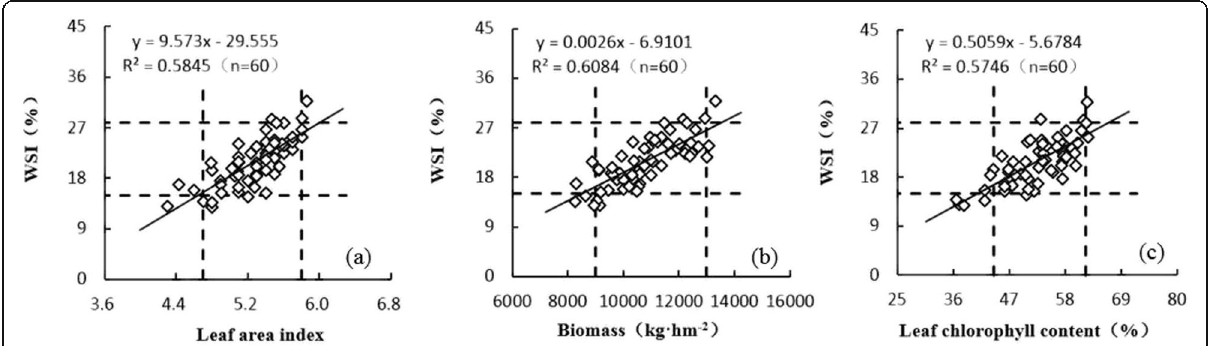
Fig. 4 Relationship between leaf area index ( a ), biomass ( b ), leaf chlorophyll content ( c ) and